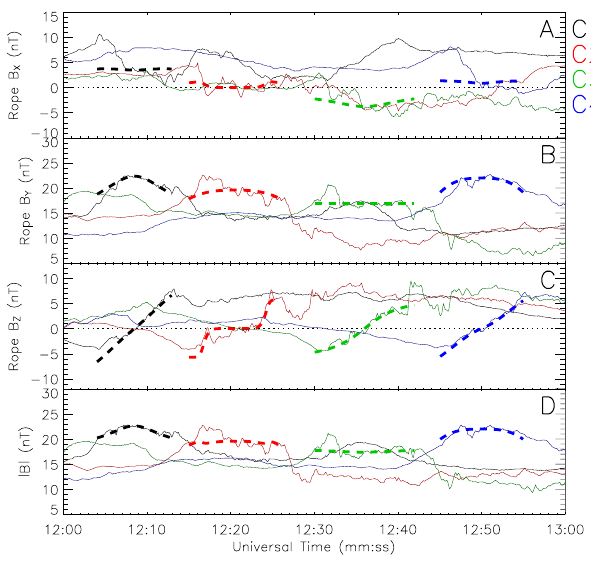
Fig. 4. Model fits for Signature 1. The thick dashed lines represent the model flux ropes, the thinner solid lines the FGM data. Colours as before. Panels (A–C) show the three field components in the flux rope model frame and panel (D) the total field. Data have been offset by –12, 3, 18 and 30s for C1, C2, C3 and C4, respectively.